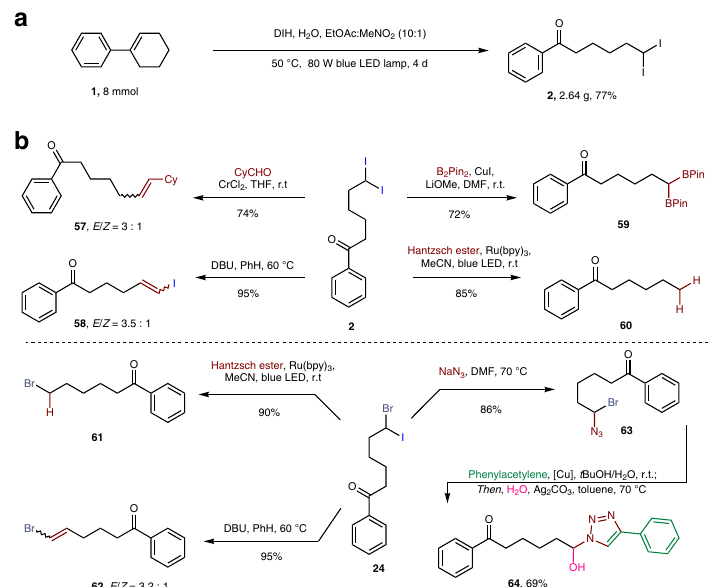
Fig. 7 Gram-scale synthesis and further synthetic diversi fi cation. a Gram-scale synthesis. b Synthetic diversi fi cation. B 2 Pin 2 bis (pinacolato)diboron,